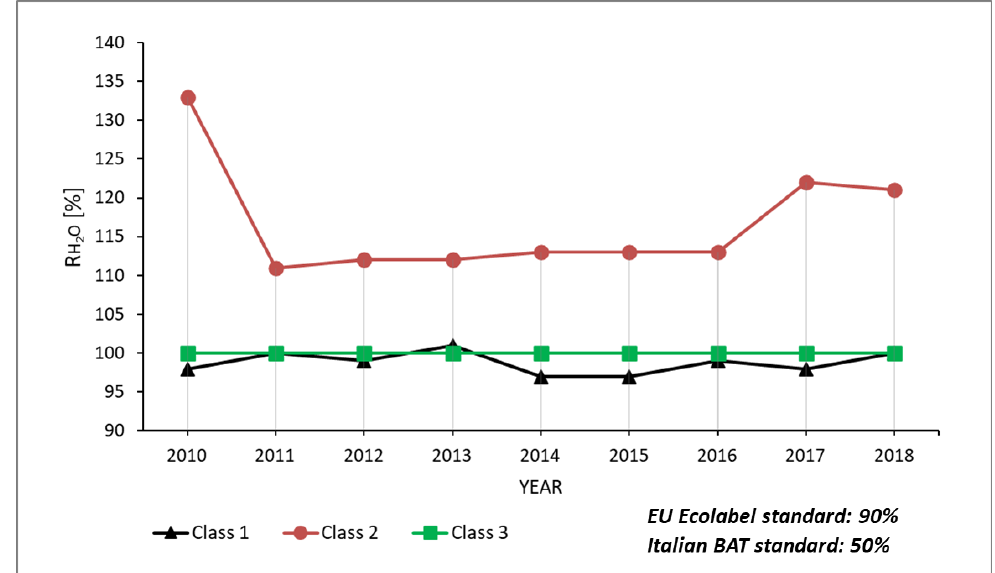
Figure 9. Trend for the recycling ratio of water (R H 2 O ). The data for all the three production classes are reported. are